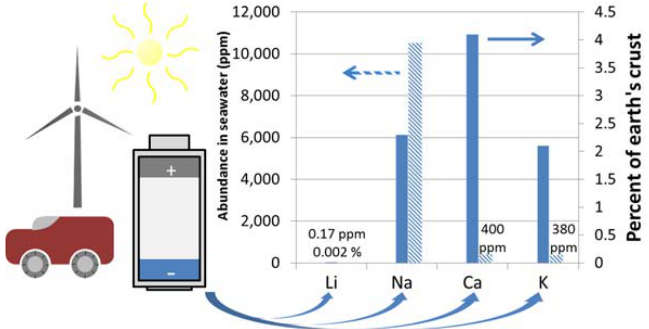
Figure 1. Abundance of rechargeable battery relevant Li, Na, Ca, and K metals in seawater and in the earth’s crust [1,2].